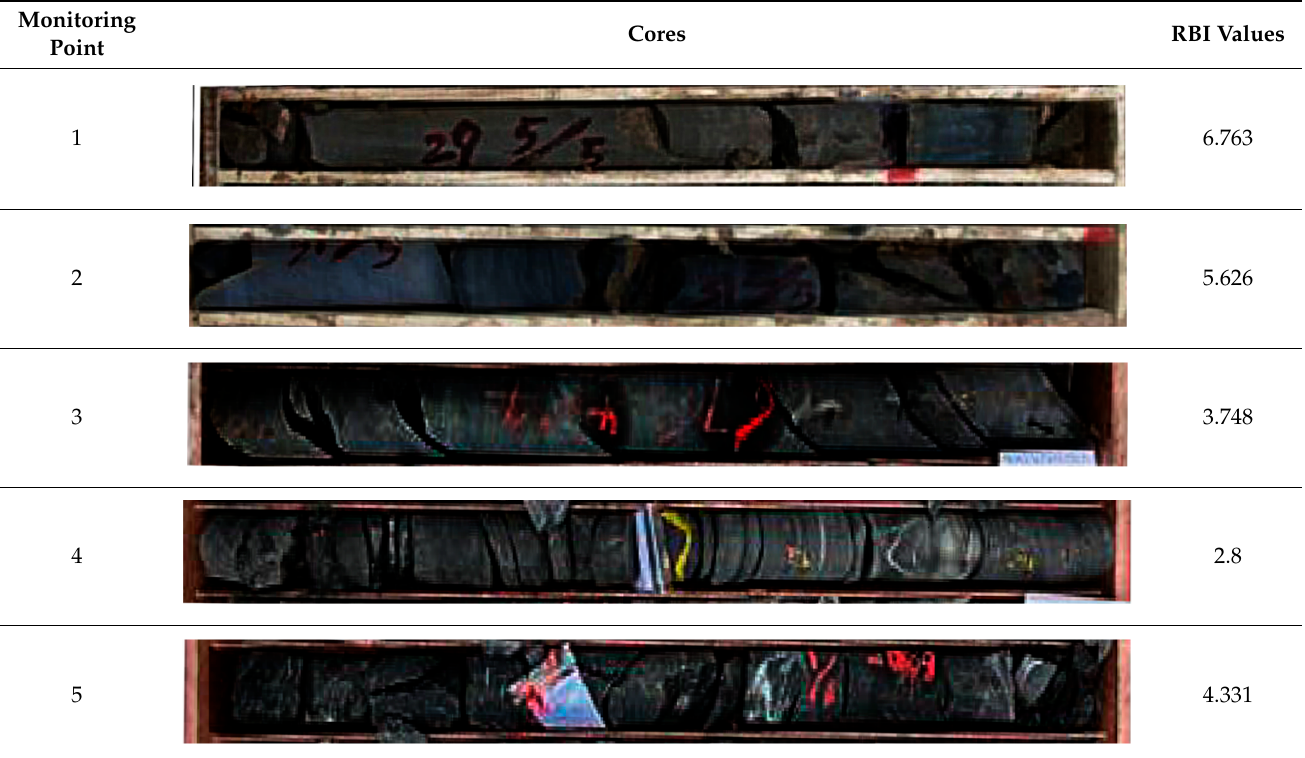
Table 6. Basic parameters of the surrounding rock mass at each monitoring position.